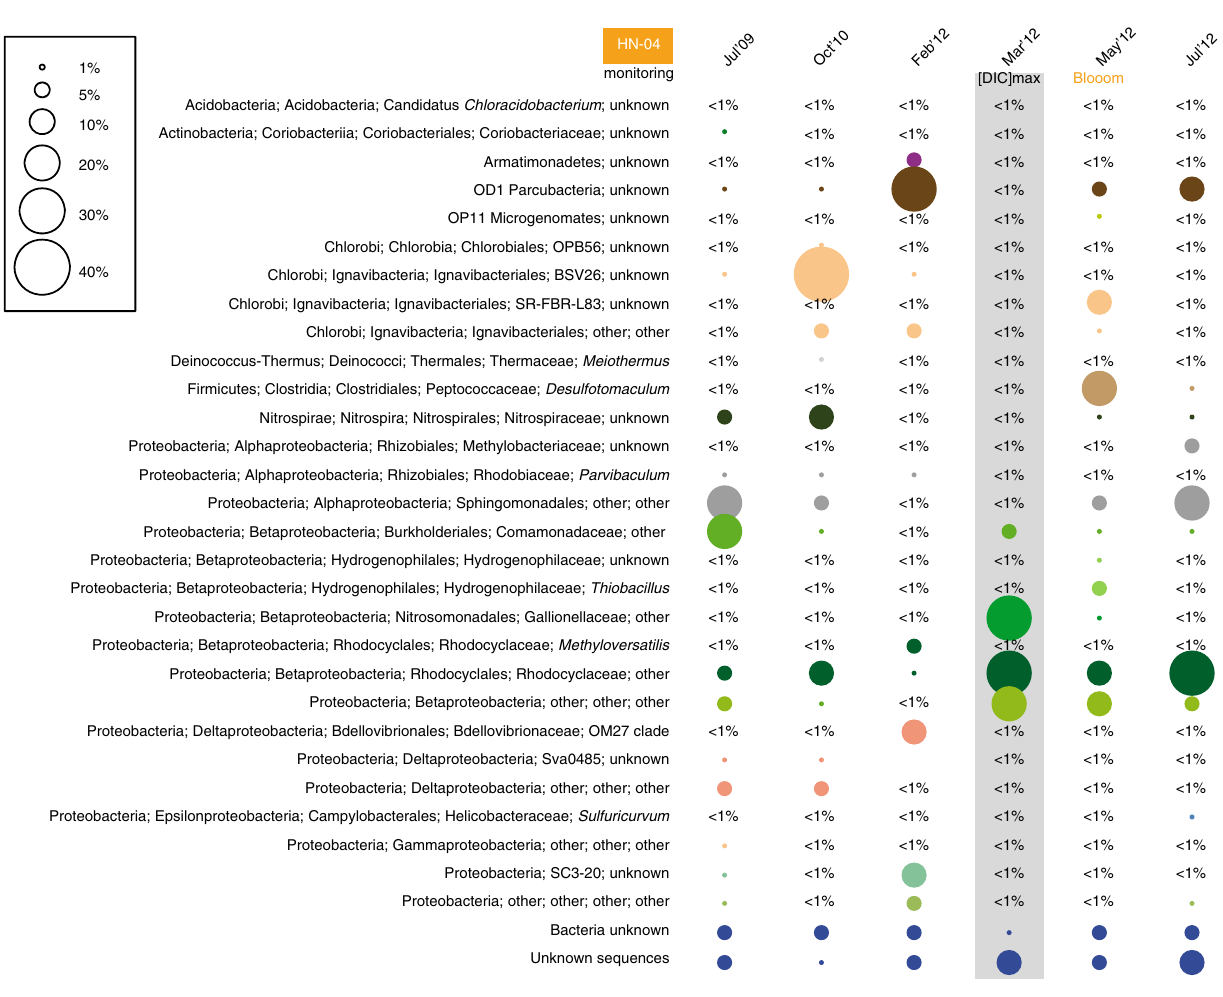
(Fig. 1a; Supplementary Fig. 2a, b, d; Supplementary Table 3)